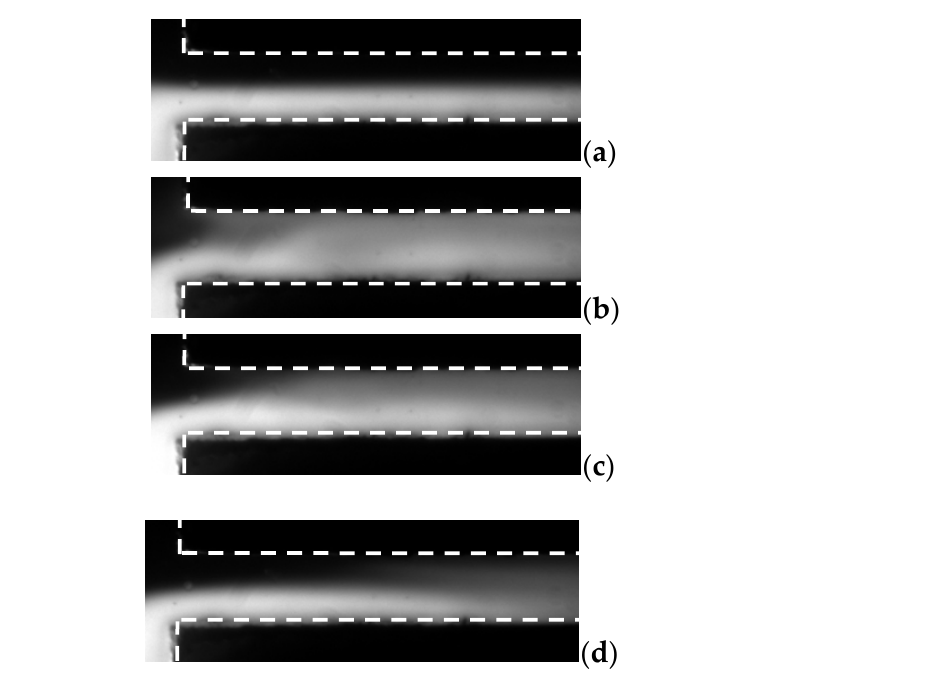
Figure 10. Visualization and comparison of mixing result in the micromixer with different Re numbers. ( a ) No voltage, ( b ) Re = 0.1, ( c ) Re = 0.3, and ( d ) Re = 0.5. Applied E A was kept at 500 V/cm with f AC = 10